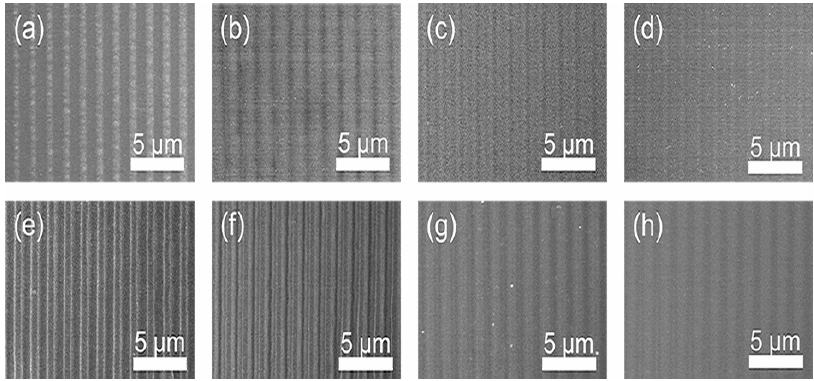
Figure 4. SEM images of microstructures with laser fluence of ( a ) 1.6 J/cm 2 ; ( b ) 1.2 J/cm 2 ; ( c ) 0.8 J/cm 2 ; ( d ) 0.4 J/cm 2 ; and number of pulses of ( e ) 50; ( f ) 20; ( g ) 8; ( h ) 5.